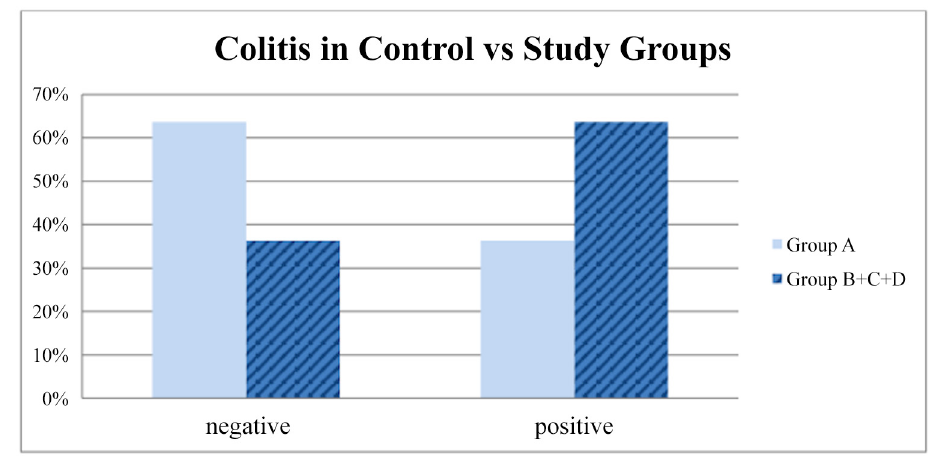
Fig 2. The percentage of colonic inflammation in the control group (A) compared to all “ occlusion ” groups (B+C+D) together (P = 0,16).